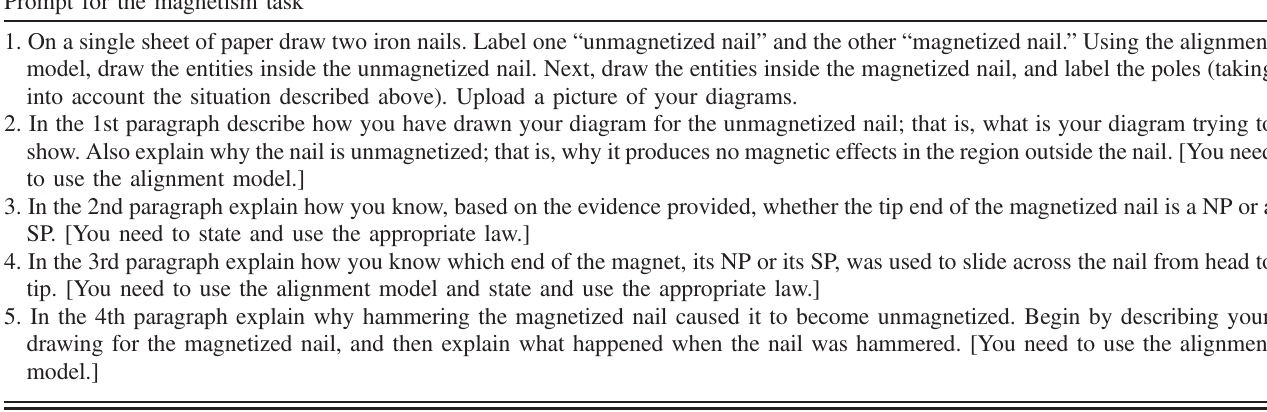
TABLE II. The prompt and evaluation questions for the magnetism CPR task. In addition to the prompt, background material introduces the scenario and includes a video of a nail being magnetized by rubbing with a permanent magnet, and demagnetized by hammering. There were a total of 10 yes or no evaluation questions for the model of magnetism unit CPR task. Students are instructed to give an overall score equal to the number of yes responses to the evaluation questions. Prompt for the magnetism